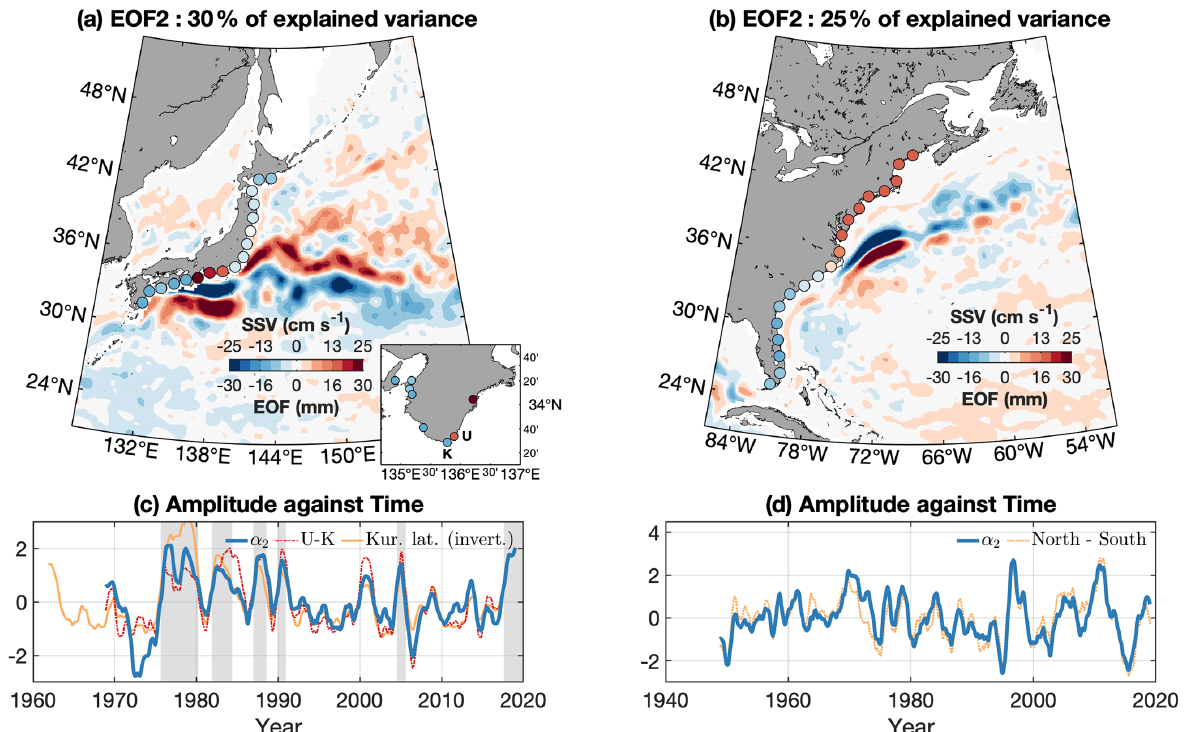
Figure 6. The second EOF ( φ 2 ) of the gridded tide-gauge-based sea-level anomaly (circular markers) from the Pacific (a) and the Atlantic (b) . The associated principal components α 2 are shown as thick dark blue lines for the Pacific (c) and Atlantic (d) . Also in (c) , the Kuroshio southernmost latitude south of T¯okai is represented by the solid orange line (positive values indicate Kuroshio further to the south); the difference between sea level at Uragami and Kushimoto is represented by the dot-dashed red line, and grey shading represents periods of typical large meander (JMA, 2018). In (d) , the dashed yellow line is the sea-level difference between the averages of northern and southern groupings of tide gauges, as in McCarthy et al. (2015). All time series in (c) and (d) are normalized. For each basin, colour shading in (a) and (b) is the sea surface velocity magnitude composite difference based on the principal component α 2 (period of α 2 > + 2 / 3 minus period of α 2 < − 2 / 3). The arbitrary threshold of ± 2 / 3 was used, but taking any number between 0 and 1 leads to similar patterns. The inset in (a) presents the regression coefficient obtained when the principal component is regressed on the original tide gauges, with a zoom-in on the Kii